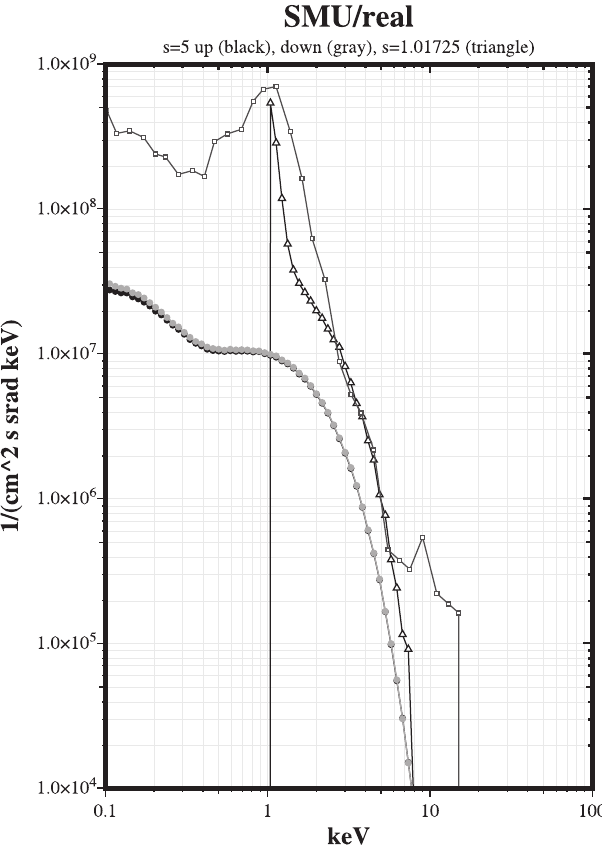
Fig. 9. SMU/randboost: same as model SMU/real (Fig. 8) but with random boosts added. The peak width is